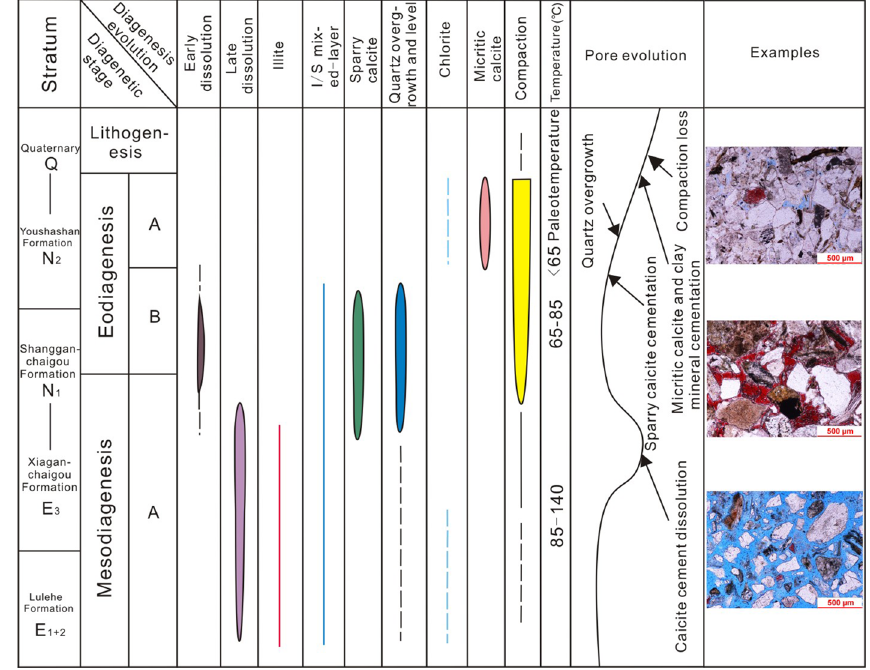
and porosity of sandstones in the Upper Xiaganchaigou Formation (E 32 ) in the Lengdong Area, Qaidam Basin. Pressure coefficient refers to Tang (2016)